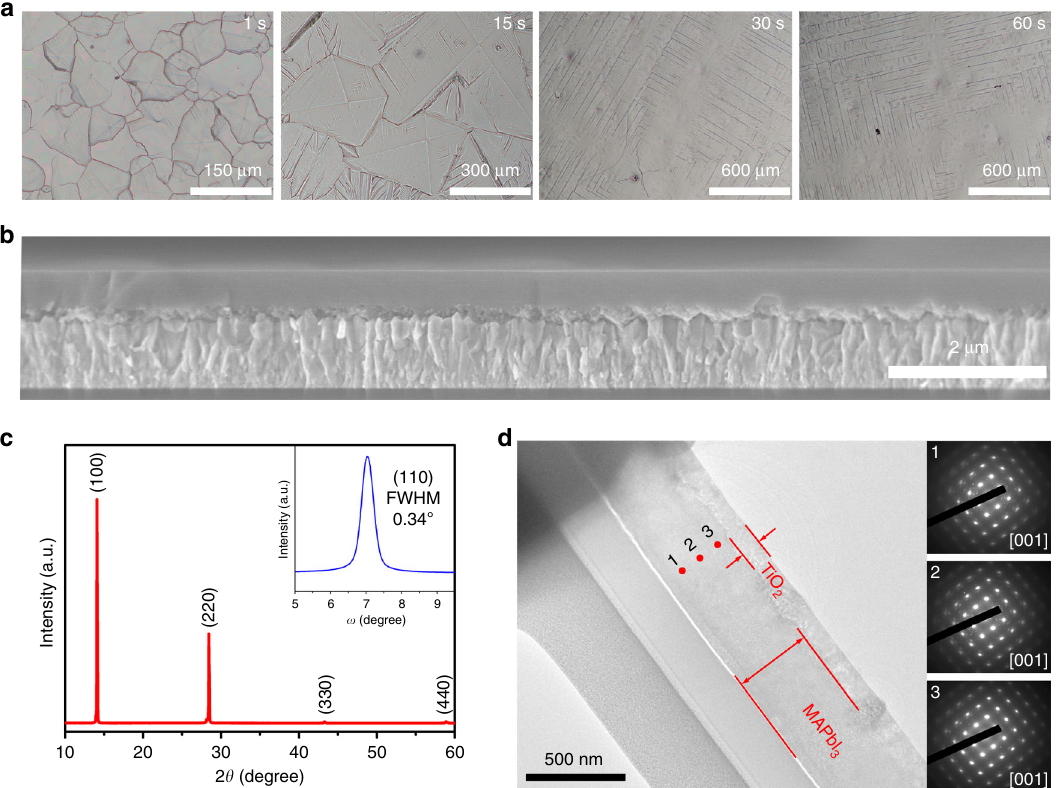
Fig. 2 The characterization of MAPbI 3 perovskite fi lms. a Optical microscopic images of the MAPbI 3 perovskite fi lms prepared from the liquid intermediate with different degassing times (1, 15, 30, and 60 s) in the internal. b Cross-sectional scanning electron microscopic (SEM) image of the large- grain MAPbI 3 perovskite fi lm. c X-ray diffraction (XRD) pattern and rocking curve (inset) of the large-grain MAPbI 3 perovskite fi lm. d Cross-sectional transmission electron microscopic (TEM) image and selected area electron diffractions (SAED) taken from the different locations (labeled 1 – 3) from bottom to top in the perovskite fi